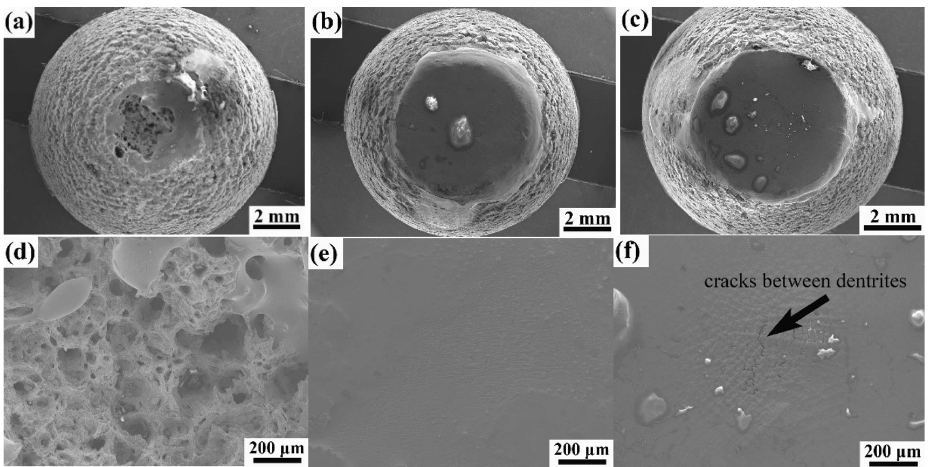
Figure 10: The macrostructure and microstructure of the fracture morphologies of alloy B1 specimens strained at different temperatures: (a, d) 1100°C; (b, e) 1150°C; (c, f)